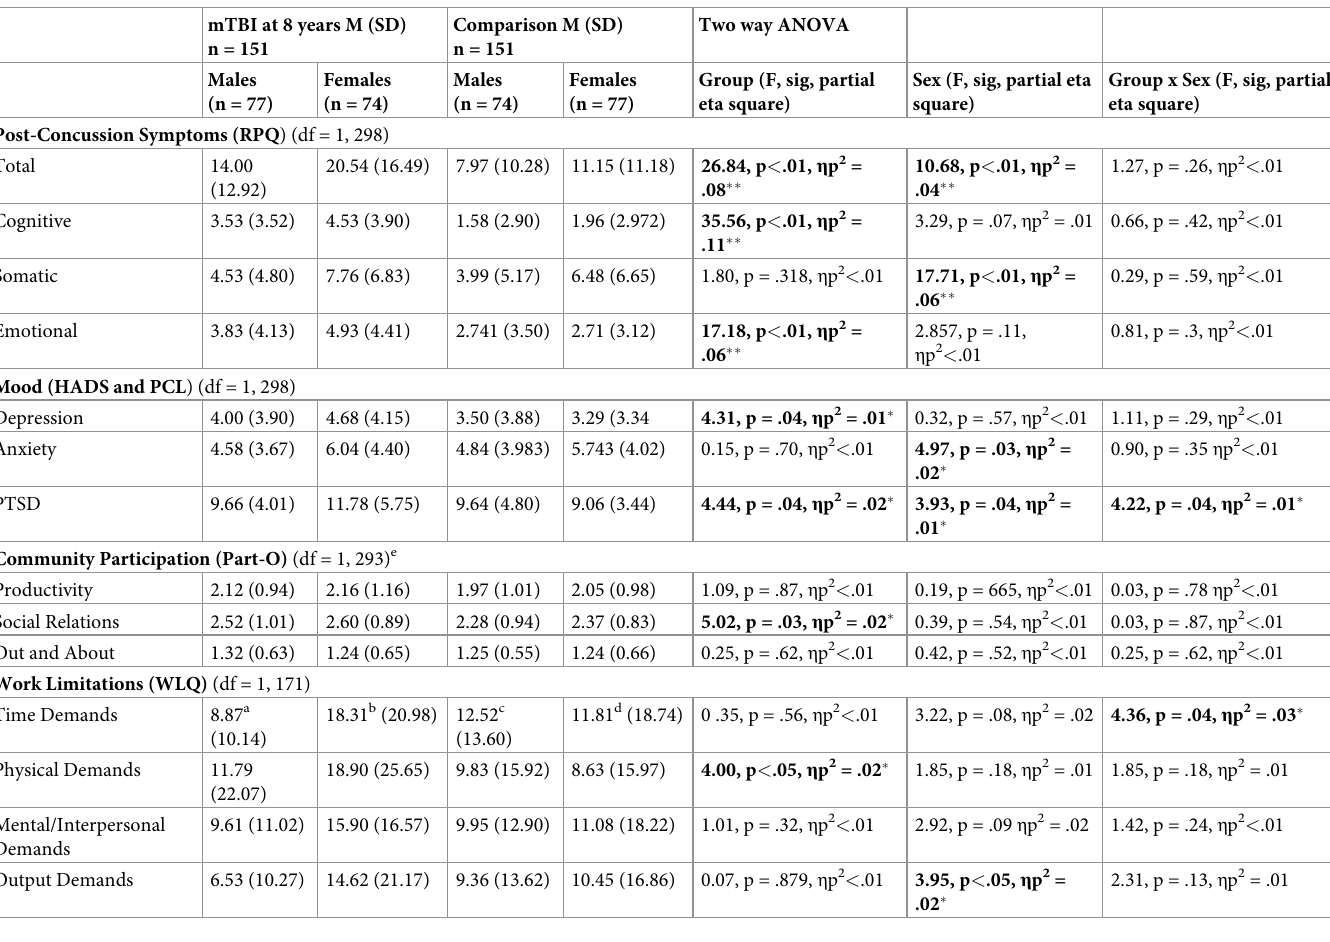
Table 3. Descriptive and inferential statistics for the males and females in the mTBI (8-years post-injury) and comparison groups for the outcome measures. Data are presented as mean (standard deviation) for males and females in the mTBI group 8 years post-injury and a TBI-free comparison group for measures of symptom and symptom burden and functional outcomes. Two-way ANOVAs were conducted to explore differences by group and